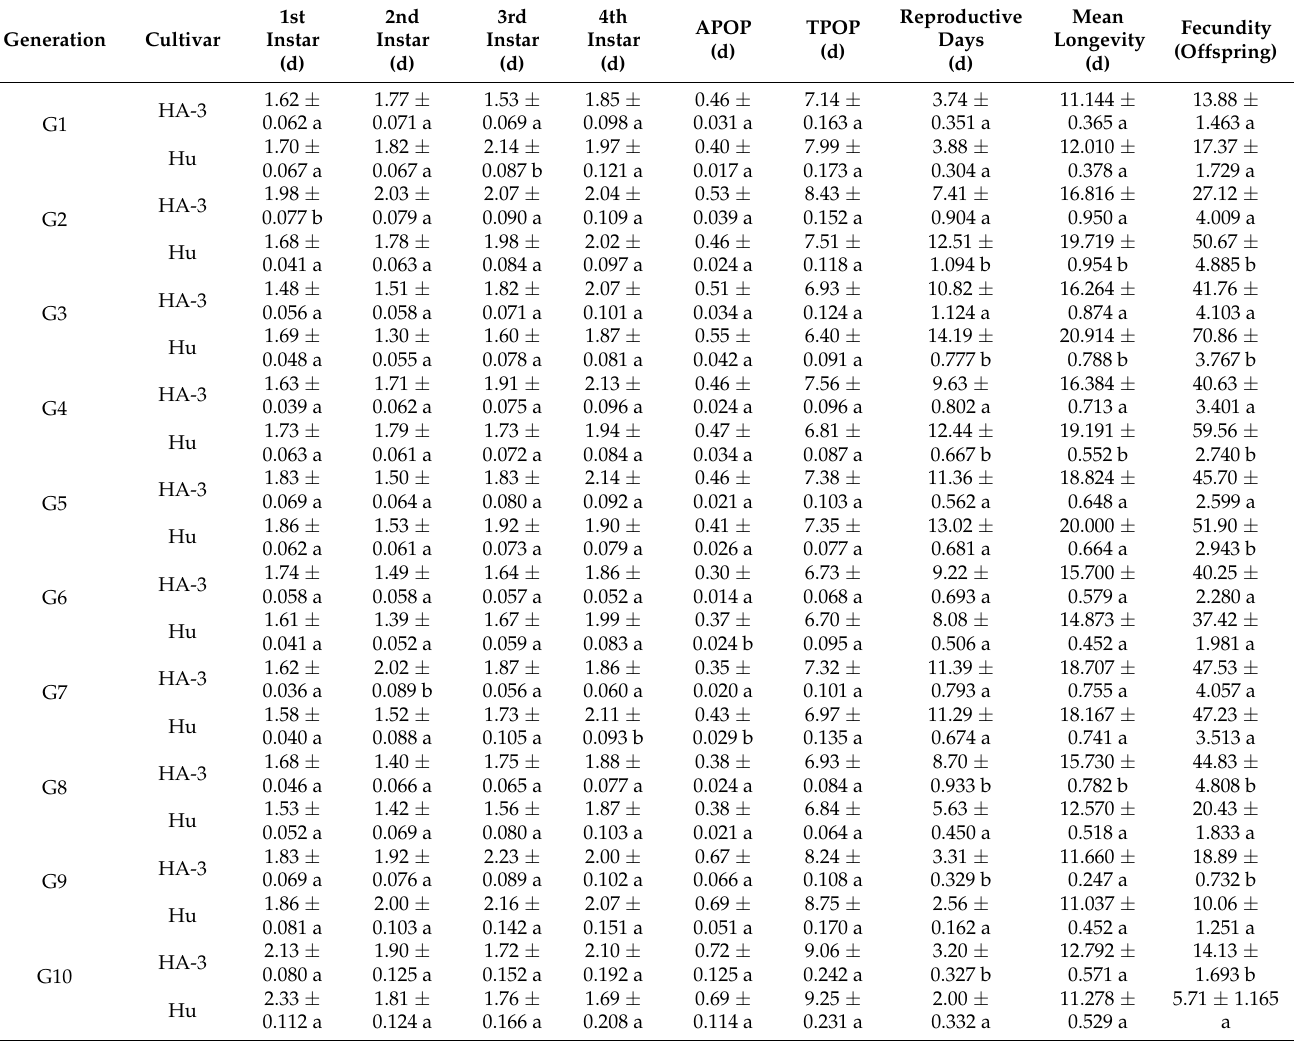
in Table 4. The immature instar developmental times, ATOPs, and TPOPs varied between the strains (except for a few periods), but there was no significant difference ( p > 0.05); compared to the HA-3 population, the G2-G8 Hu populations were markedly lower and the G9-G10 Hu populations were visibly higher. For the reproductive days, mean longevity, and fecundity (offspring), the G1-G5 Hu populations were obviously higher, while the G6-G10 Hu populations were obviously lower than the HA-3 group. Meanwhile, the results showed an increase in G1-G5 and reduction in G6-G10 between the two populations as a whole. Table 4. Developmental time and fecundity of SAA on HA-3 and Hu